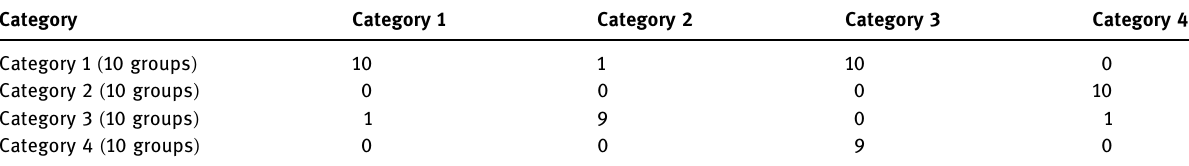
Table 2: Risk index